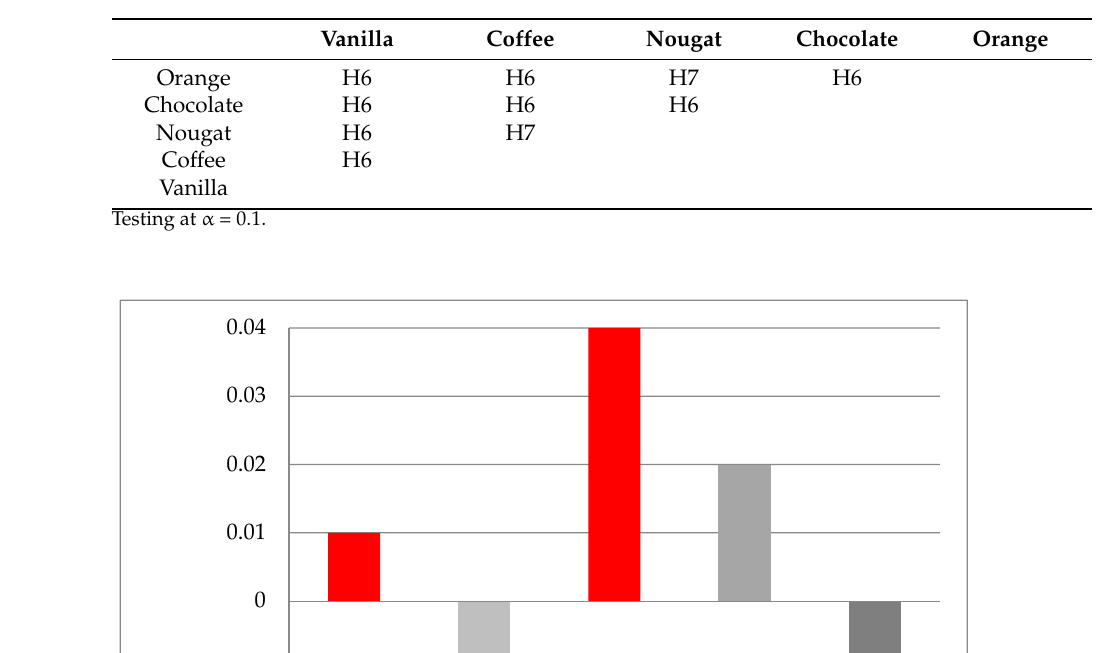
Table 1. Kruskal–Wallis test—comparison of the valence of individual aromas.